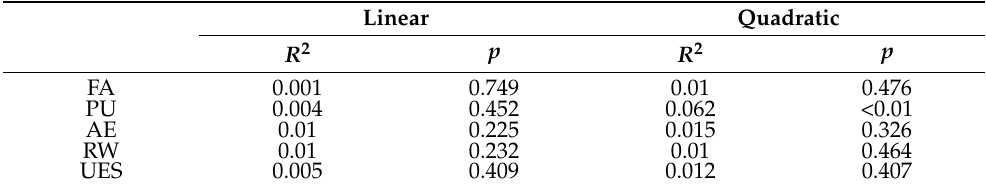
Table 9. Standard deviation of motion in relation to user engagement scale (short form) for a linear and quadratic regression model. Linear Quadratic R 2 p R 2 p FA 0.0 0.859 0.001 0.931 PU 0.017 0.107 0.072 <0.01